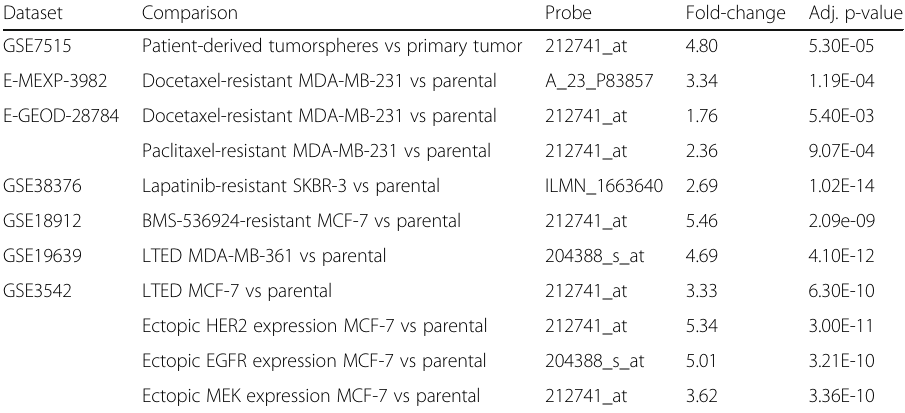
Table 1 Transcriptomic analysis of MAO-A expression from mined datasets